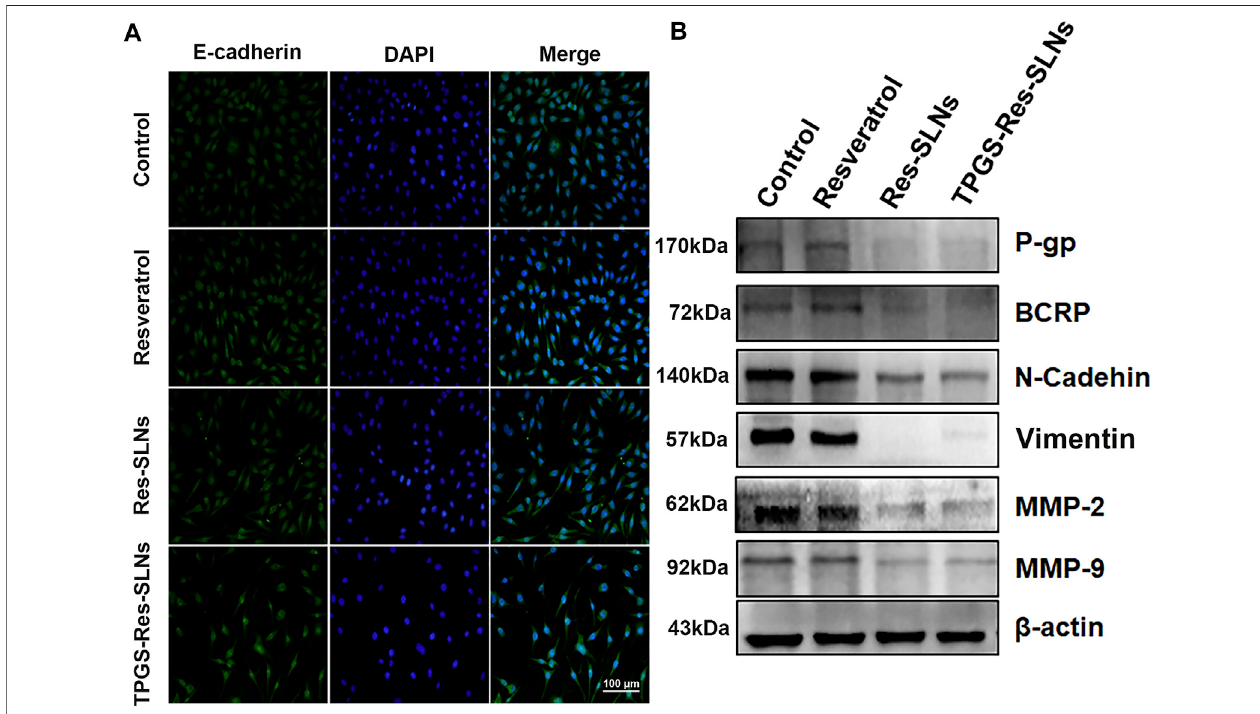
FIGURE 6 | The effect of TPGS-res-SLNs on the EMT-related protein level of SKBR3/PR cells by Immuno fl uorescence assay and Western blot. (A) Immuno fl uorescenceassaywasusedtodetectEMTrelatedproteins.SKBR3/PRcelltreatedwithResveratrol,Res-SLNsandTPGS-Res-SLNsfor48h.Untreatedcells servedasthecontrol.E-cadherinwasstainedingreen,andnucleistainedwithDAPIwereinblue. (B) ExpressionlevelofP-gp,BCRP,E-cadherin,N-cadherin,Vimentin, MMP-2, and MMP-9 in protein extracted from SKBR3/PR cells analyzed by Western blot.